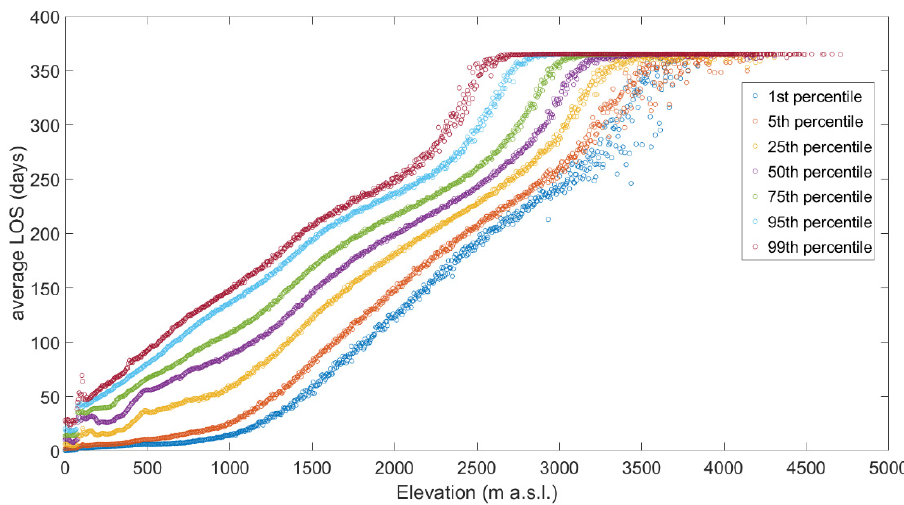
Figure 3. Quantiles of the distribution of LOS average values in the 2000–2019 period in each 5-m interval of the GAR elevation range.